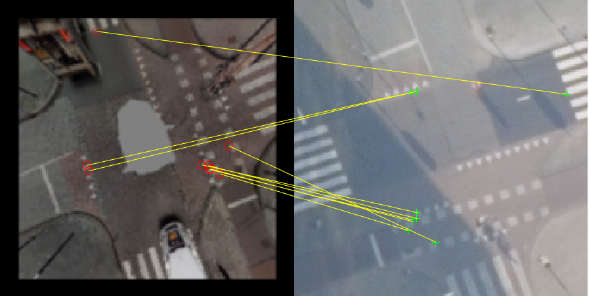
Figure 5. Matching result of one MM image (left, with car greyed out) with an aerial image (right). Strong contrast and illumination differences may hamper the registration. Please note: the MM image is north- oriented, the aerial image is flight direction (ca. west-oriented).